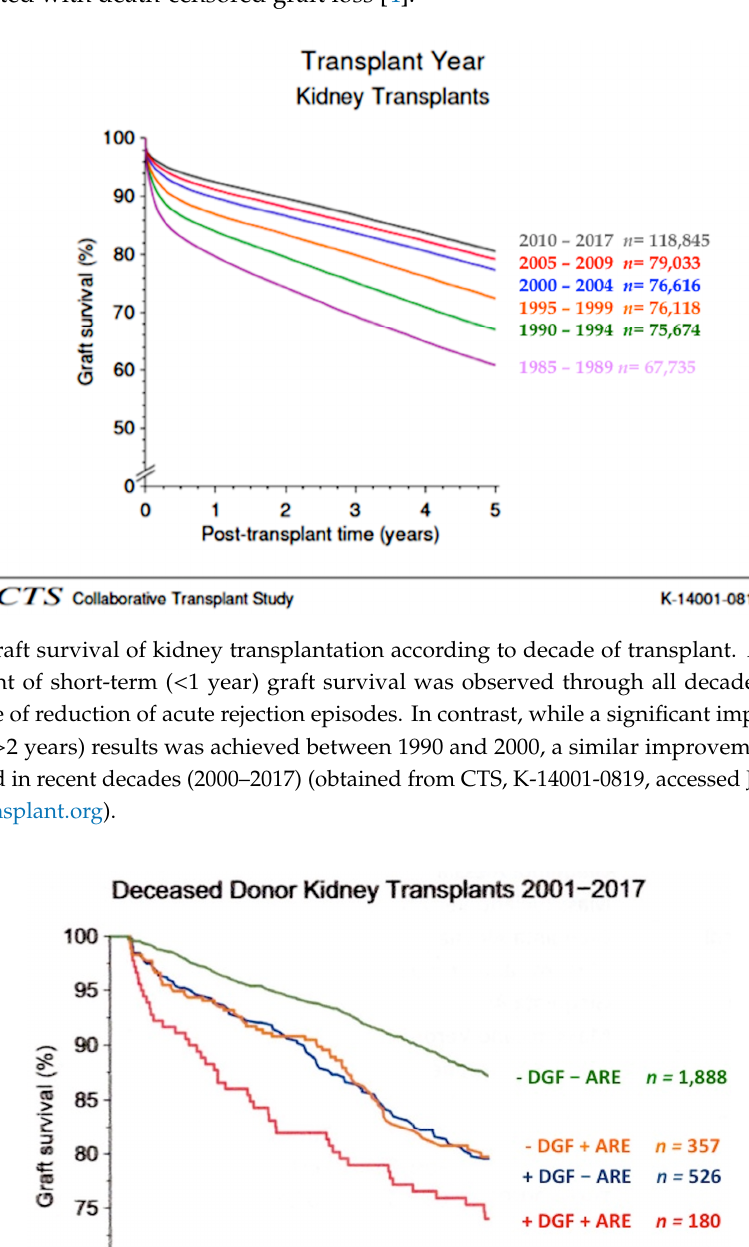
Figure 3. Influence of delayed graft function (DGF) and acute rejection (ARE) on ( A ) death-censored graft survival and on ( B ) patient survival in kidney transplantation from deceased donor. A group of patients without DGF and ARE (−DGF/ARE) was compared with a group of patients with both DGF and ARE (+DGF/ARE). Graft survival was calculated by censoring death patients. Patient survival was considered as the time from transplant to the patient’s death. Early adverse events had a significant impact on both death-censored graft survival as well as patient survival, with influence on death-censored graft survival more pronounced in patients DGF+/ARE+ (obtained from CTS newsletter, 4:2018, accessed 20/01/2020, www.ctstransplant.org).